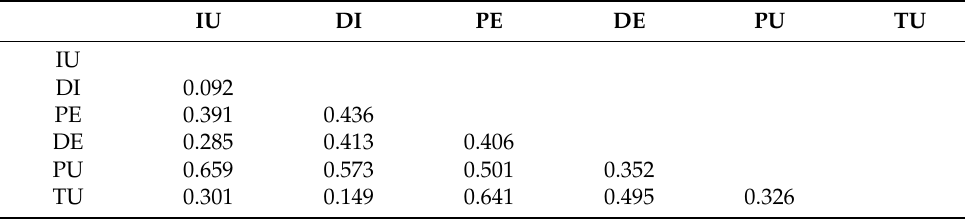
Table 6. Heterotrait–monotrait ratio (HTMT).